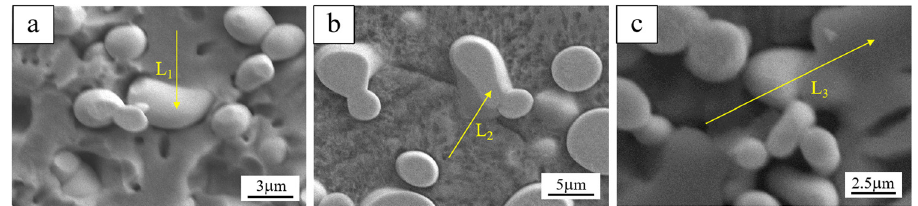
Figure 6: Typical W/Cu interface in microstructures of WCu composites microalloyed with ( a ) Fe, ( b ) Ni, and ( c )